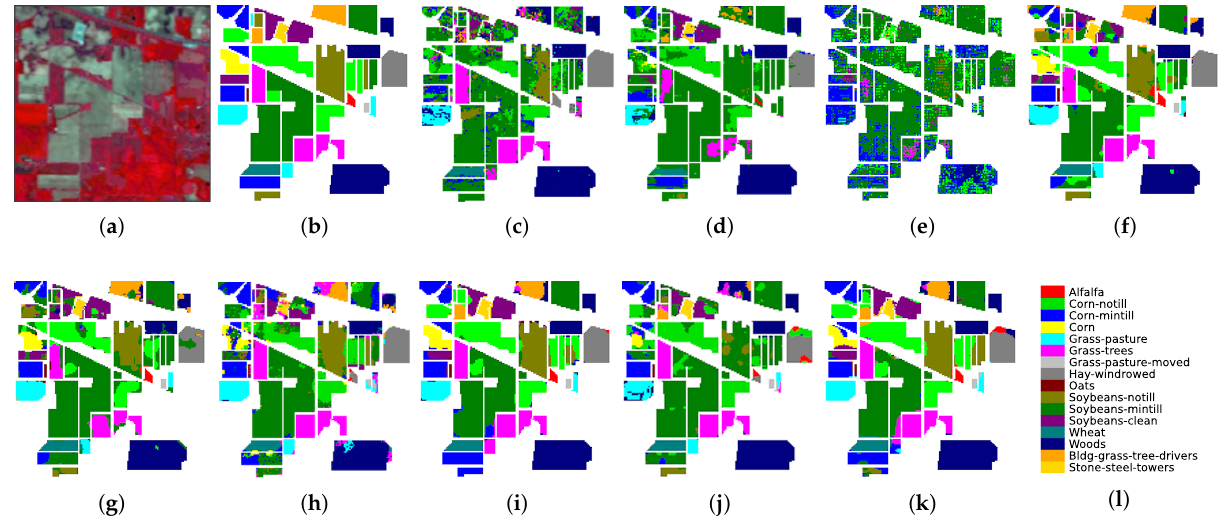
Figure 7. Classification maps of different methods on the IP dataset. ( a ) False-color; ( b ) Ground truth map; ( c ) 2D-CNN; ( d ) 3D-CNN; ( e ) Res-Net; ( f ) SSRN; ( g ) A2S2K; ( h ) MAFN; ( i ) DBDA; ( j ) A-SPN; ( k ) AETF-Net; ( l ) Color